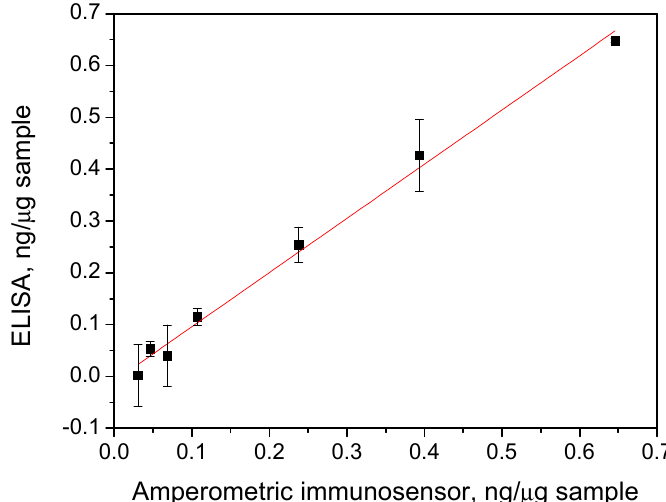
Figure 5. Comparison of the results obtained with the magnetoimmunosensor and the ELISA methodologies. Dots in the graph correspond to (from left to right) BxPc3, MCF-7, KM12SM, SW620, KM12C, MDA-MB-436, and SW480, respectively. Error bars are estimated as a triple that of the standard deviation ( n = 3).